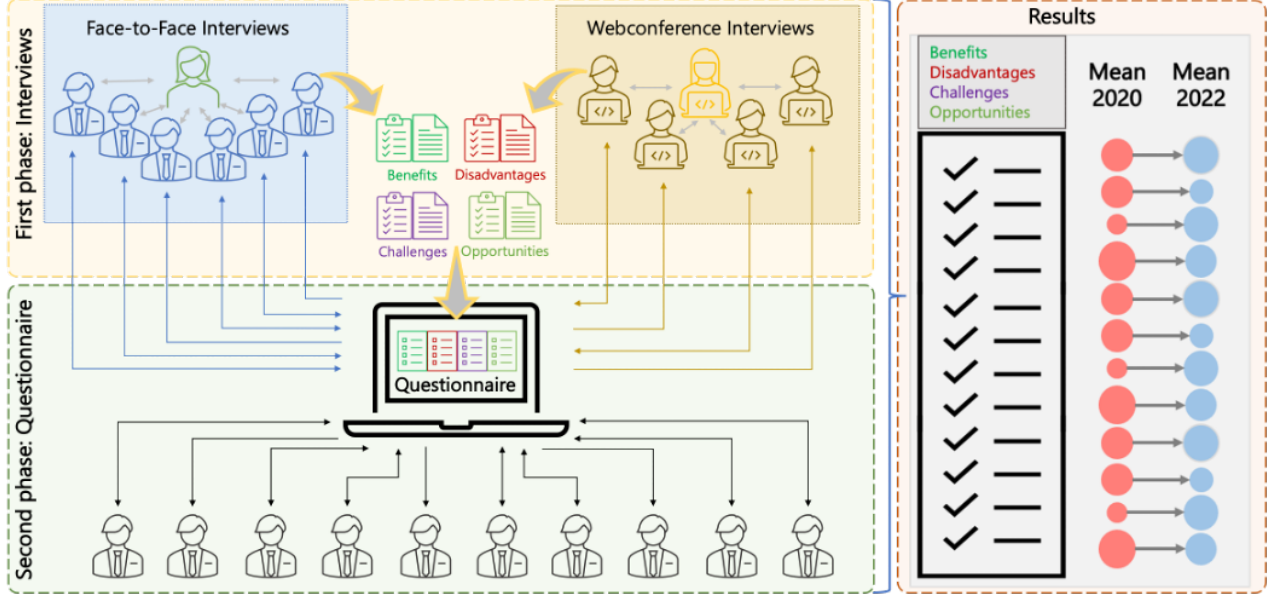
Figure 1. The framework of methodological phases and procedures carried out in the research. Source: elaborated by the authors.